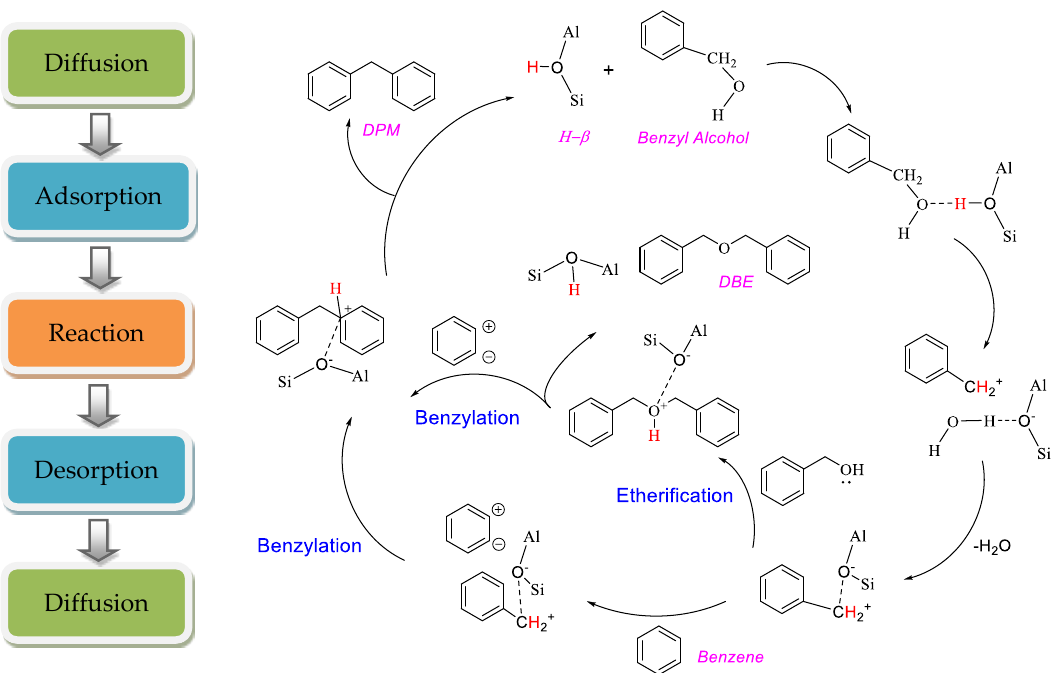
Figure 13. Inferred mechanism of main heterogeneous catalysis process ( left ). The reaction pathway of benzylation and etherification ( right